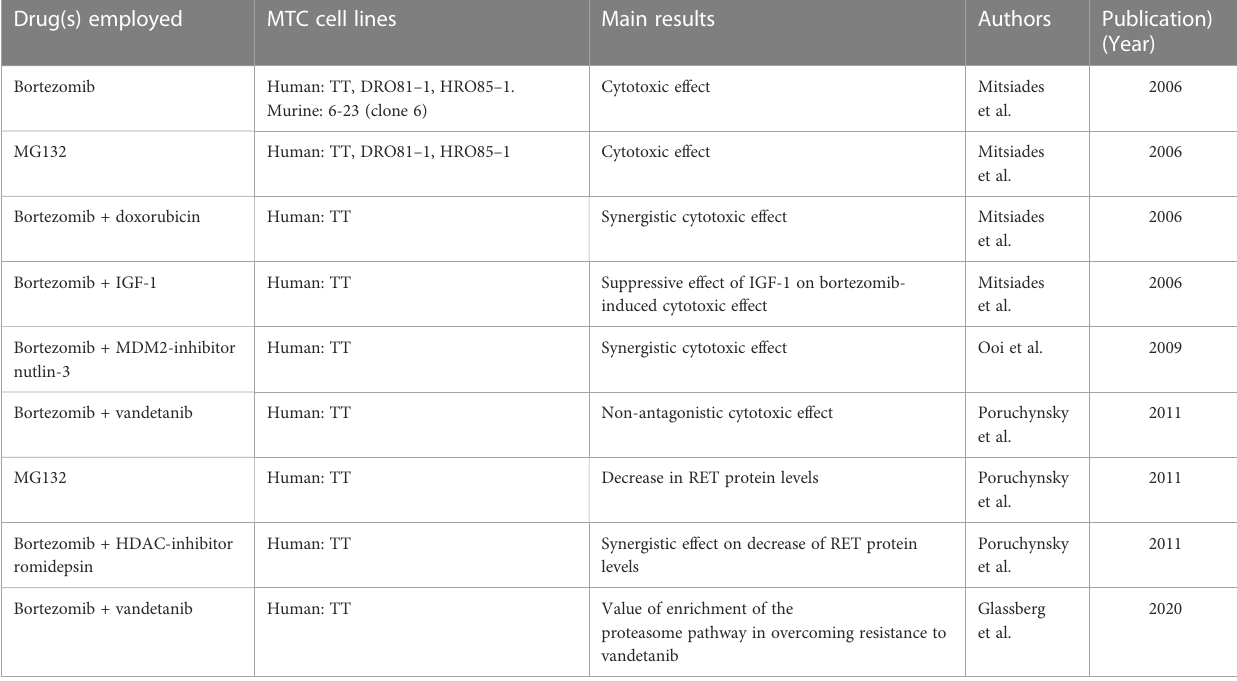
TABLE 2 Results of in vitro studies of PrIns (alone or in combination with other drugs) on MTC cell (results are listed in chronological order). Drug(s) employed MTC cell